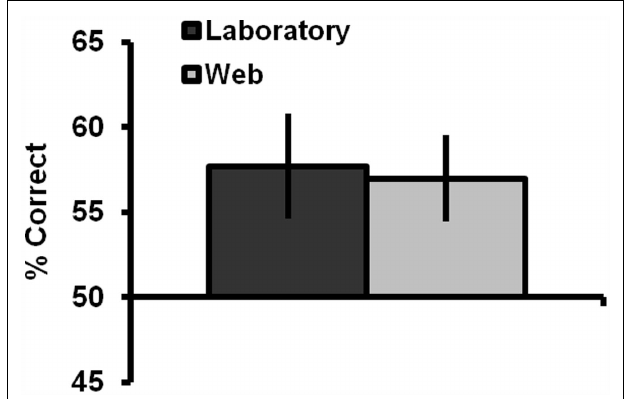
FIGURE 4 | Correct responses (as %, ± 1 SEM) for trials where the test was conducted in the laboratory (experiment 2) or over the web (experiment